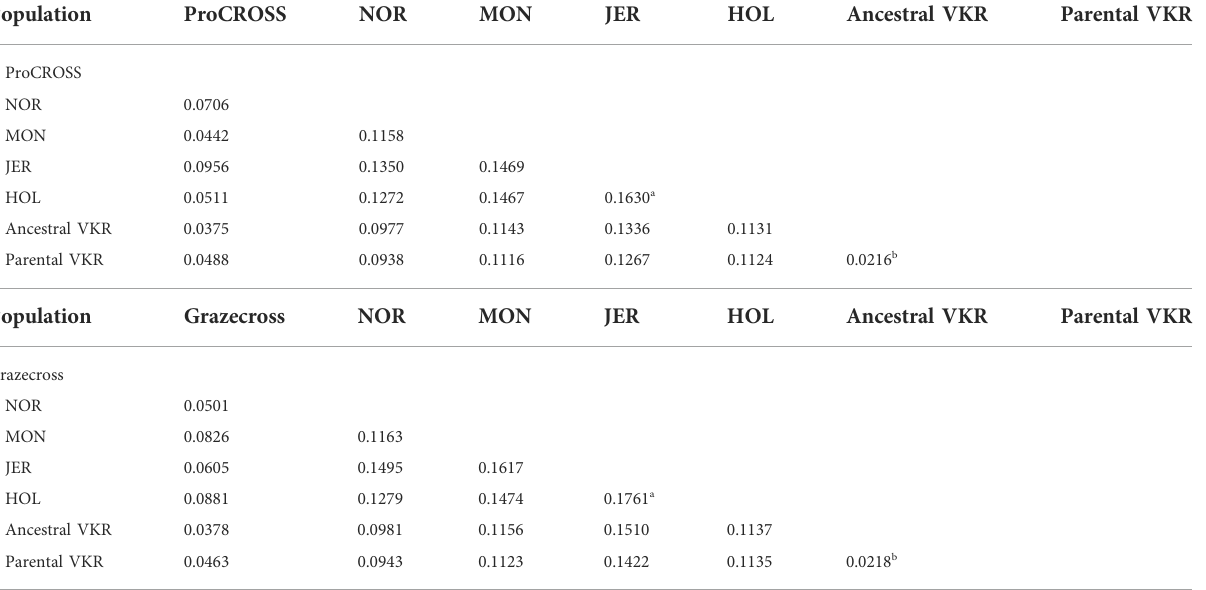
TABLE 2 Pairwise genetic differentiation (F ST ) value for all populations used in the ProCROSS and Grazecross breeding